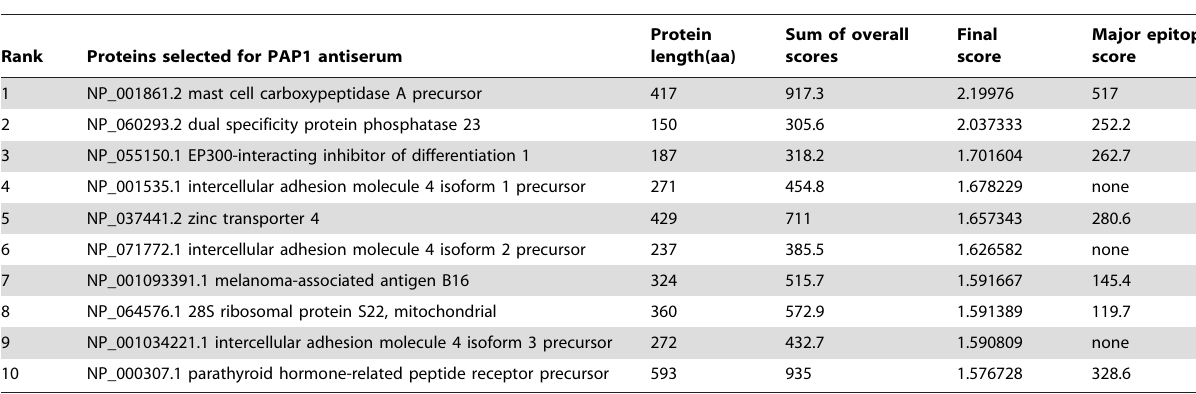
Table 3. Top candidate antigens selected by the SAS for the melanoma patient serum.